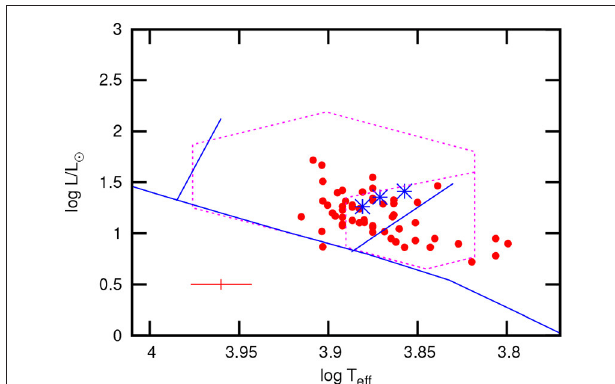
FIGURE 5 | The observed roAp pulsation frequency, ν obs , as a function of ν max , the frequency of maximum amplitude extrapolated from hot stars with solar-like oscillations. The straight line has unit slope and zero